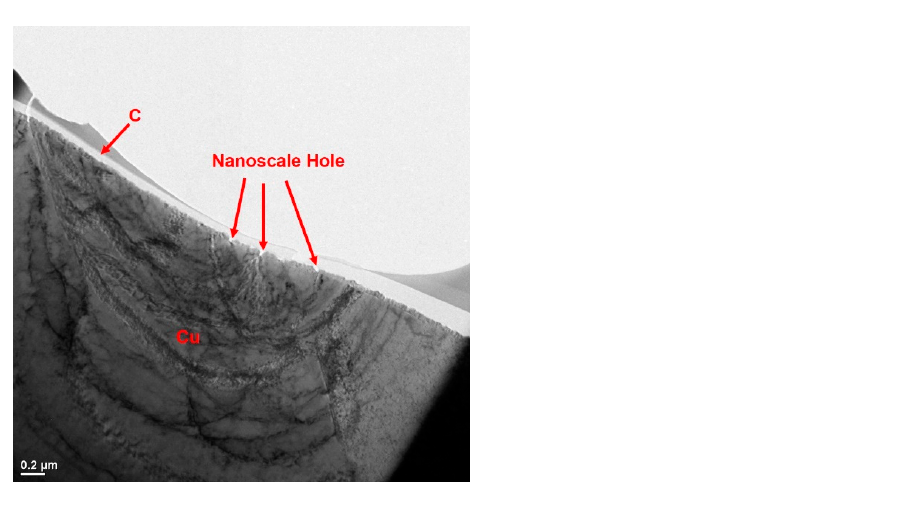
Figure A3. TEM micrograph of the TEM sample. The carbon film was grown on the copper foil substrate, which has some nanoscale holes on the surface. Scale bar in the figure is 0.2 µm.